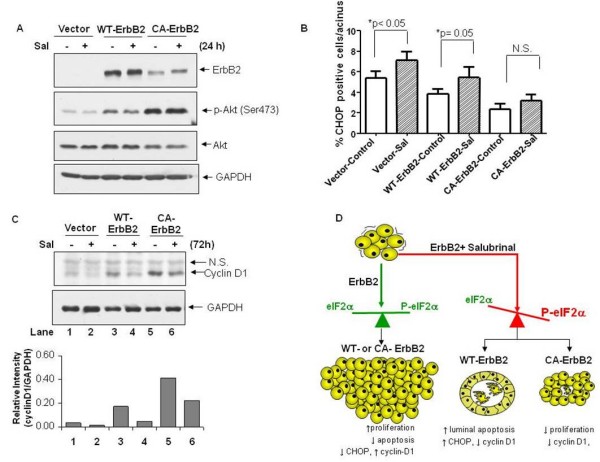
Salubrinal may restrict growth by increasing expression of CHOP and suppressing cyclin D1 levels. (A) Western blots for total ErbB2, phospho-Ser473 and total Akt levels after 24 hr salubrinal treatment (10 μg/ml) of cells grown in monolayer conditions. GAPDH was used as loading control. (B) Graph showing quantification of the percentage of CHOP positive cells per acinus, mean ± SEM. Statistical significance was determined using the unpaired t-test with p < 0.05 defined as statistically significant. N.S - not significant. Note the modest increase in CHOP expression in salubrinal-treated vector control and Wt-ErbB2 acini but not in CA-ErbB2 acini. (C) Western blots (top panels) for cyclin D1 levels after 72 hr salubrinal treatment (10 μg/ml)of cells grown in monolayer conditions. GAPDH was used as loading control, N.S-non-specific band. Bottom graph, Cyclin D1 protein levels were quantified by scanning densitometry and normalized to GAPDH.(D) Schematic depicting the growth-inhibitory effects of increased eIF2α phosphorylation on aberrant acinar morphogenesis induced by ErbB2.